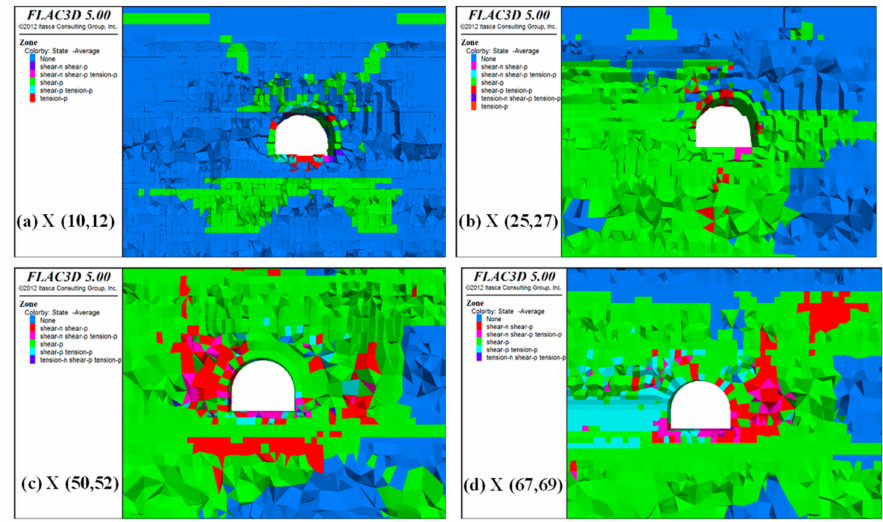
Figure 11. Plastic zone range of the four monitoring areas after excavation of electromechanical chamber.